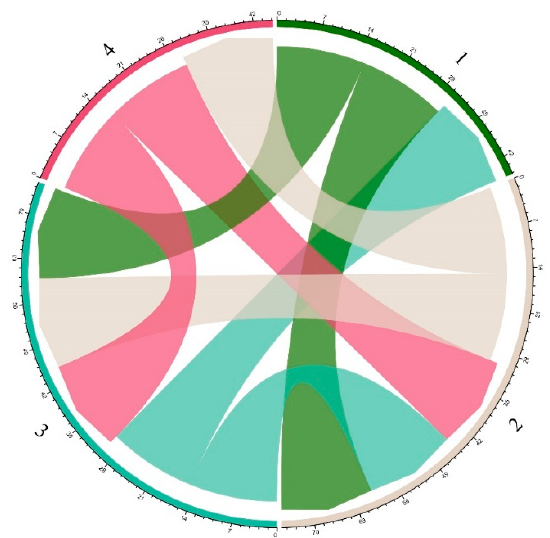
Figure 4. The improved chord graph of OD flows.